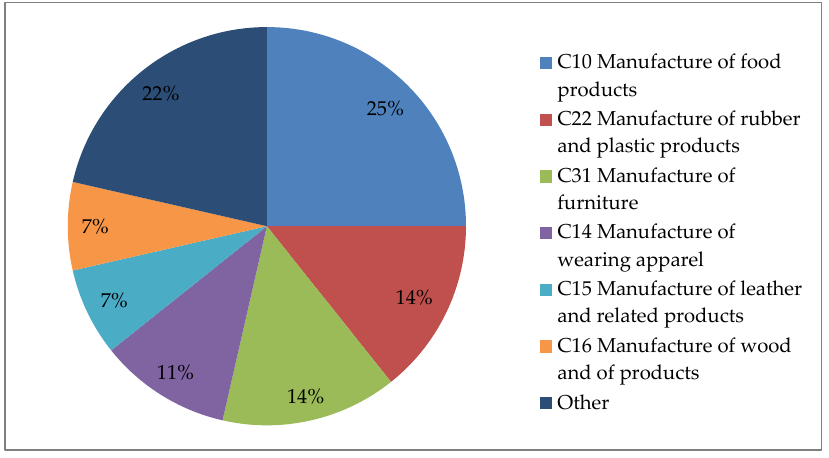
Figure 2. Albanian participants type profile.